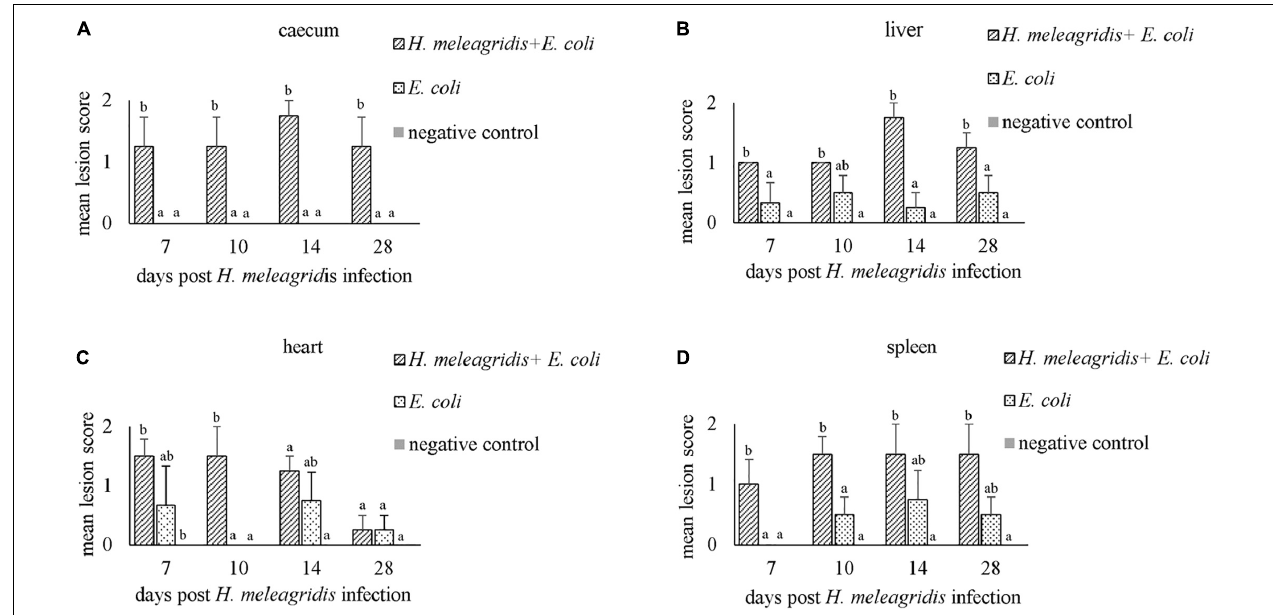
FIGURE 3 | Average histopathological lesion scores in caecum (A) , liver (B) , heart (C) and spleen (D) . Bars with different letters within each sampling point denote significantly different values.